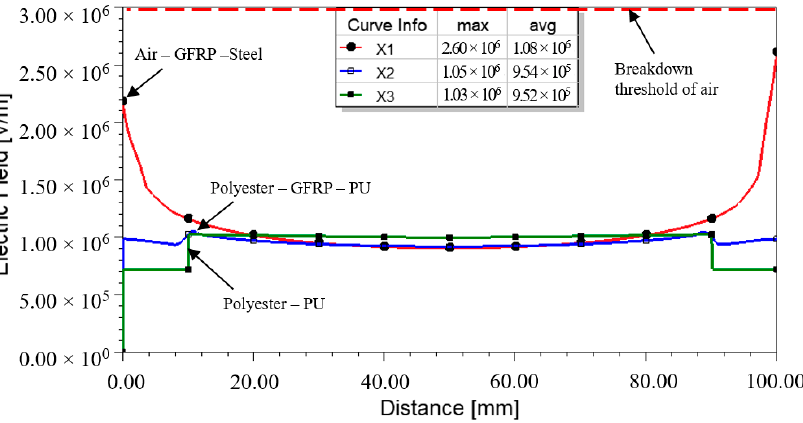
Figure 16. E ‐ field profiles across X1, X2, and X3 during the peak of voltage. Field plot on the outer surface of the crossarm sample revealed that the higher E ‐ field stress was confined at every corner, as shown in Figure 17, whereby the highest E ‐ field on the surface was 2.60 × 10 6 V/m. The field distribution explained why most of the flashover occurred at the corners, as revealed in Figure 10.